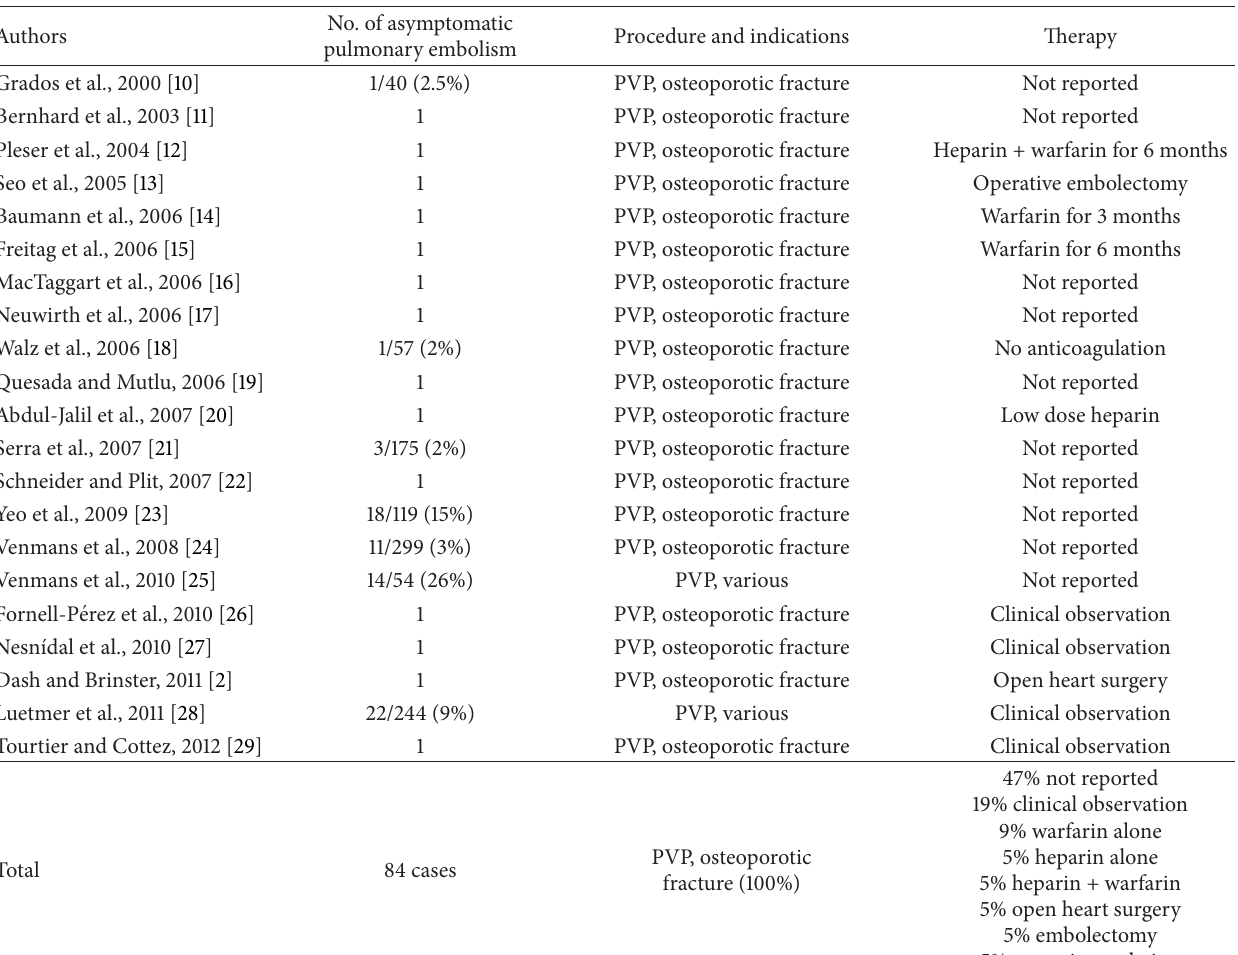
Table 1: Case reports and series of patients with asymptomatic pulmonary embolism after vertebroplasty, from PubMed database, queries: “complication of vertebroplasty,” “bone cement pulmonary embolism” (modified and ampliated from [7]).